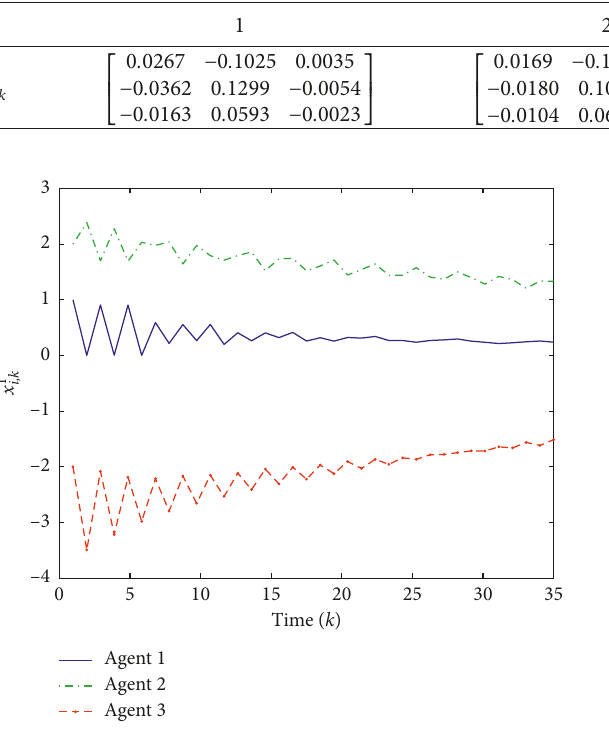
Figure 1: The state trajectories of x 1 controller.